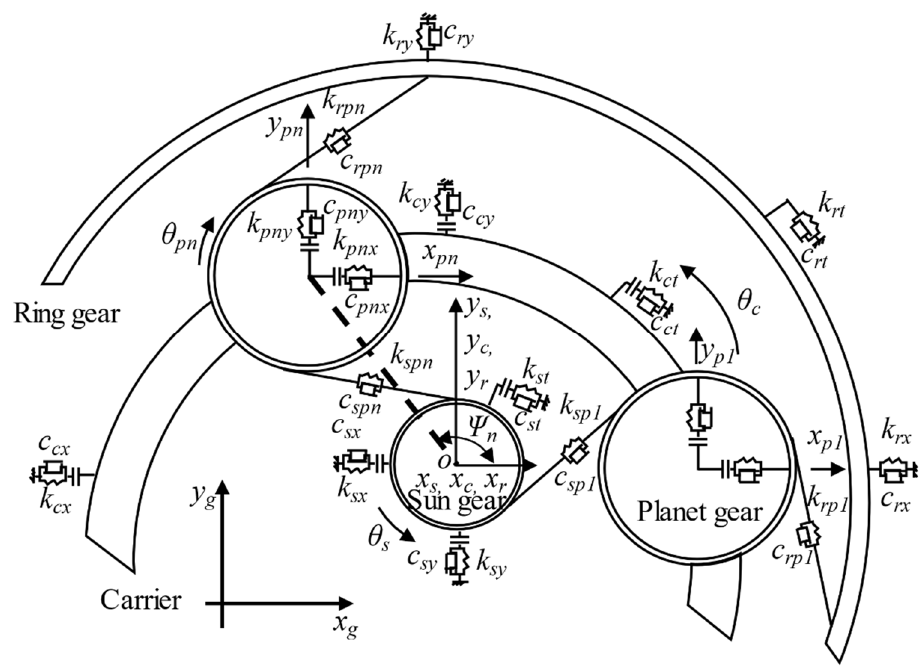
Figure 7. Lumped parameter model of planetary gear set [29].